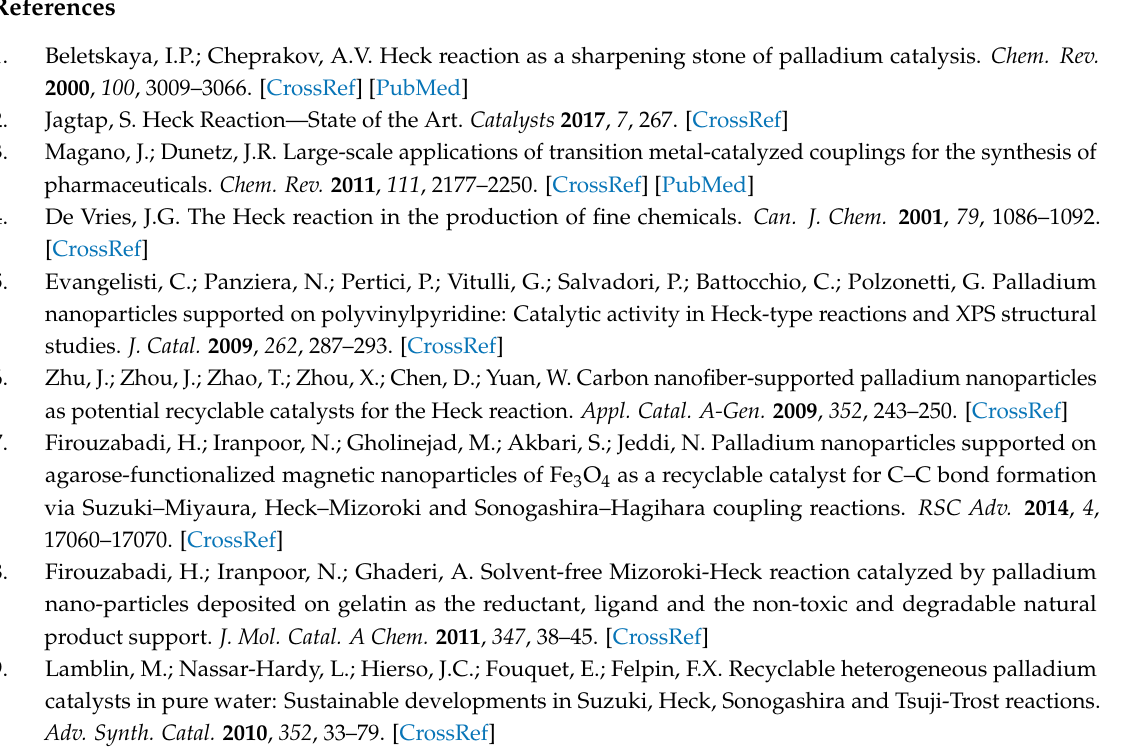
Supplementary Materials: The following are available online: Figure S1: Crystal structure of GTL native and modified together with the lid area marked key amino acids, Table S1: Suzuki-Miyaura cross coupling of bromobenzene (BB) with phenylboronic acid (PBA) catalyzed by bionanohybrid, Table S2: Suzuki-Miyaura cross coupling of bromobenzene (BB) with phenylboronic acid (PBA) catalyzed by bionanohybrid. Author Contributions: D.L.-T. and B.d.l.R. performed the experiments; J.M.P. designed and supervised the